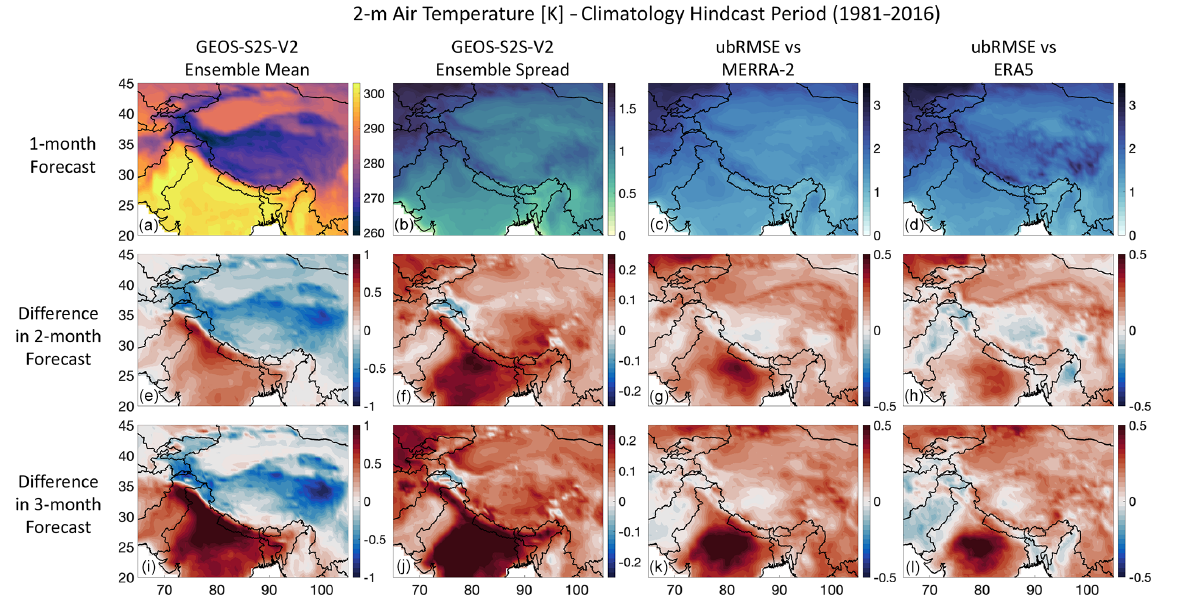
Figure 7. Screen-level (2m) air temperature (T2M) metrics in HMA; (a) shows the climatology (long-term mean) from the GEOS-S2S 1-month forecast for the hindcast period (1981–2016); (b) shows the ensemble spread from the GEOS-S2S 1-month forecast, calculated as the standard deviation of the model ensemble at each grid cell; (c, d) show the ubRMSE when comparing the GEOS-S2S 1-month forecast to MERRA-2 and ERA5 respectively. The bottom two rows of the figures show the differences in the climatology, ensemble spread, and ubRMSE between the 2-month (e–h) and 3-month (i–l) forecasts compared to the 1-month forecast shown in the top row. Note, to calculate the difference shown in the bottom two rows, the 1-month maps in the top row are subtracted from the corresponding 2- and 3-month maps (i.e., 2-month maps minus 1-month maps and 3-month maps minus 1-month maps respectively). Therefore, red in the subfigures indicates higher values (i.e., hotter temperature, larger spread, or larger error) in the 2- and 3-month forecasts, and blue indicates lower values compared to the 1-month forecasts. The units for these plots are in